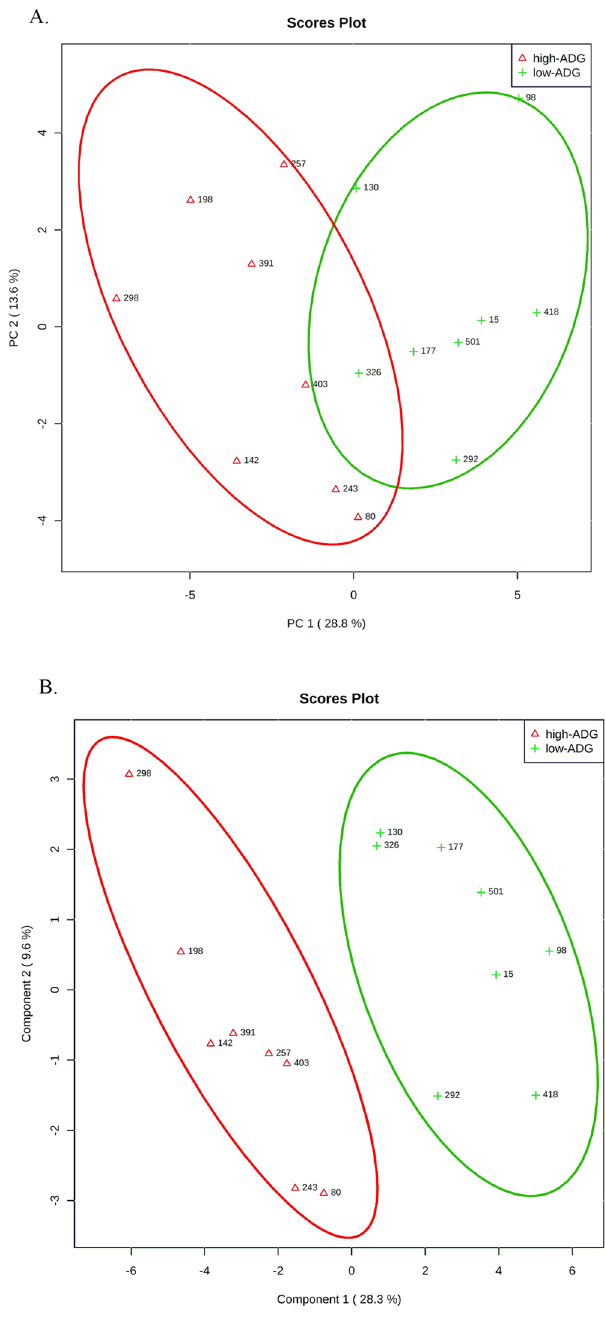
Figure 1. Ruminal metabolomic profile of the steers with the greatest average daily gain (high-ADG; open red triangle) and the least ADG (low-ADG; green plus) with similar average dry matter intake. ( A ) Principal component analysis for UPLC-qTOF 90 metabolites identified to differ between ADG by t-test ( P < 0.1). ( B ) Partial Least Square-Discriminant Analysis for UPLC-qTOF 90 metabolites identified to differ between ADG by t-test ( P < 0.1). One data point represents one